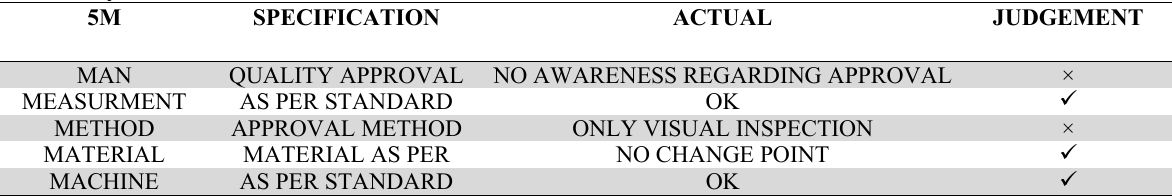
Why-Why Analysis STEPS STEP 1 STEP 2 STEP 3 STEP 4 FITMENT NOT OCCURRENCE POSSIBLE AT CUS- SERVED AT THAT CAUSE FLOW OUT CAUSE WRONG METHOD OF QUALITY